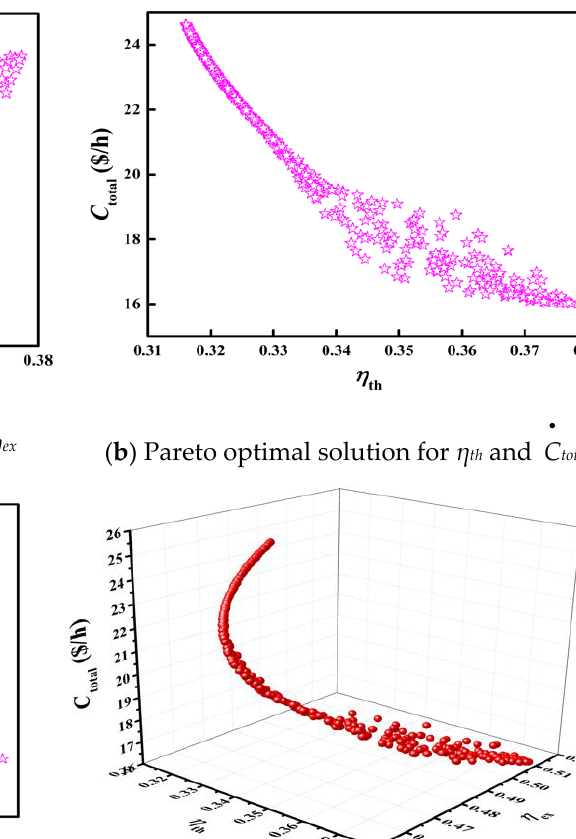
Figure 12. Three objectives Pareto optimal solution for η th , η ex , and C